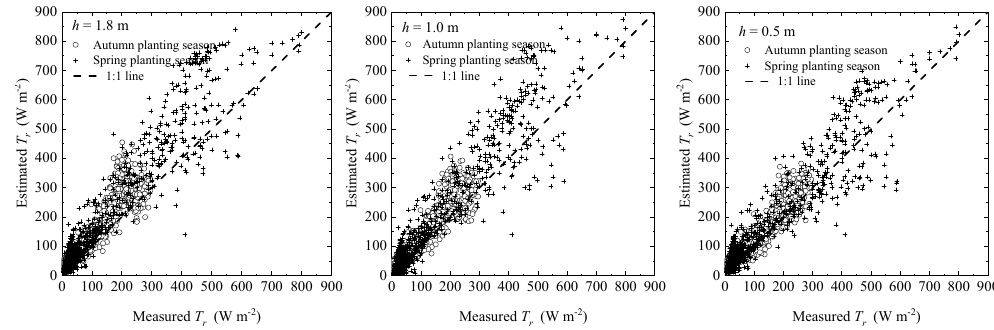
Figure 8. Comparisons of the T r estimated by the SM based on meteorological data at three observation heights and data measured using a lysimeter during the autumn (2 to 10 November 2017) and spring (2 to 10 May 2018) planting seasons. Table 1. Statistical analysis of the measured and estimated T r values using the SM in accordance with data from 2 to 10 November 2017 and from 2 to 10 May 2018. Measured Heights T ̅ r estimated T ̅ r measured a R 2